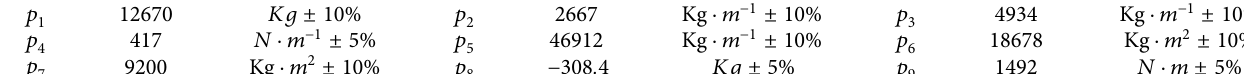
Table 1: System parameters with their uncertainties.